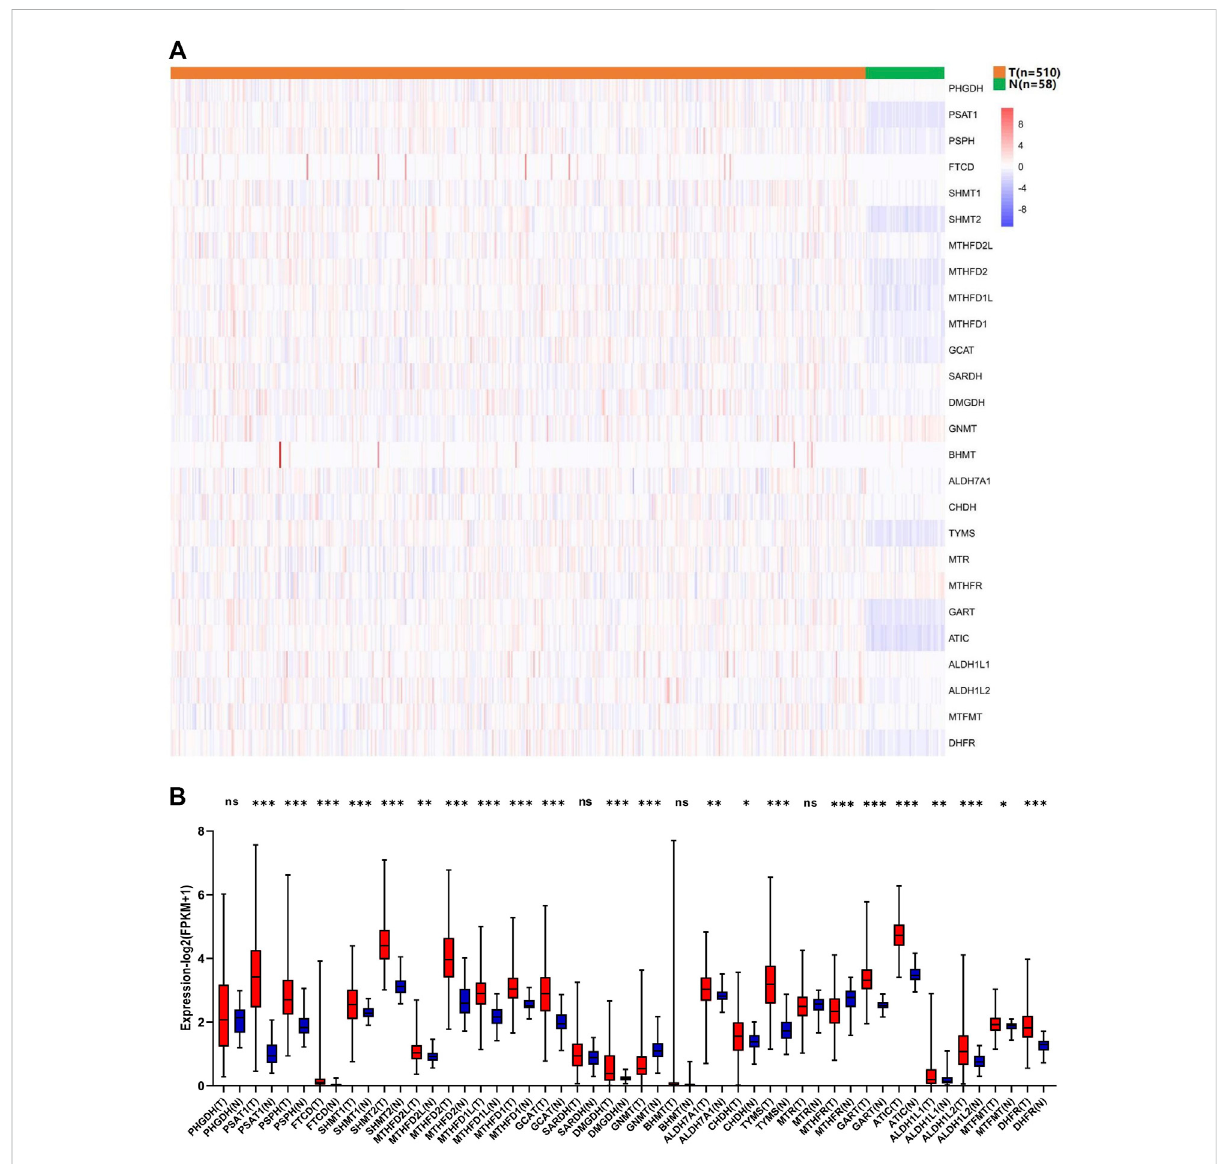
FIGURE 1 Expression levels of one-carbon metabolism associated genes in normal and tumor samples. (A) Heatmap of one-carbon metabolism associated genes expression level in each sample; (B) The expression difference of one-carbon metabolism associated genes between tumor and normal samples. * means p < 0.05; ** means p < 0.01; *** means p < 0.001; ns means no signi fi cant